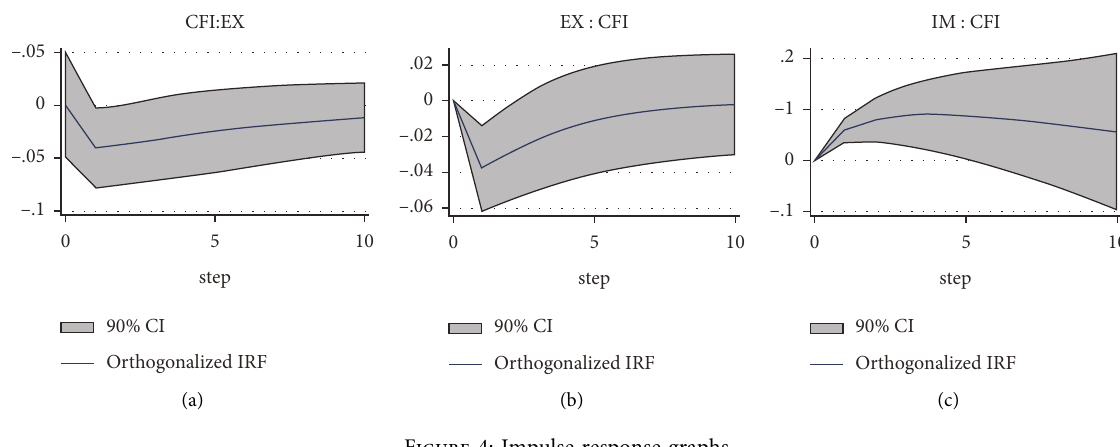
Figure 4: Impulse response